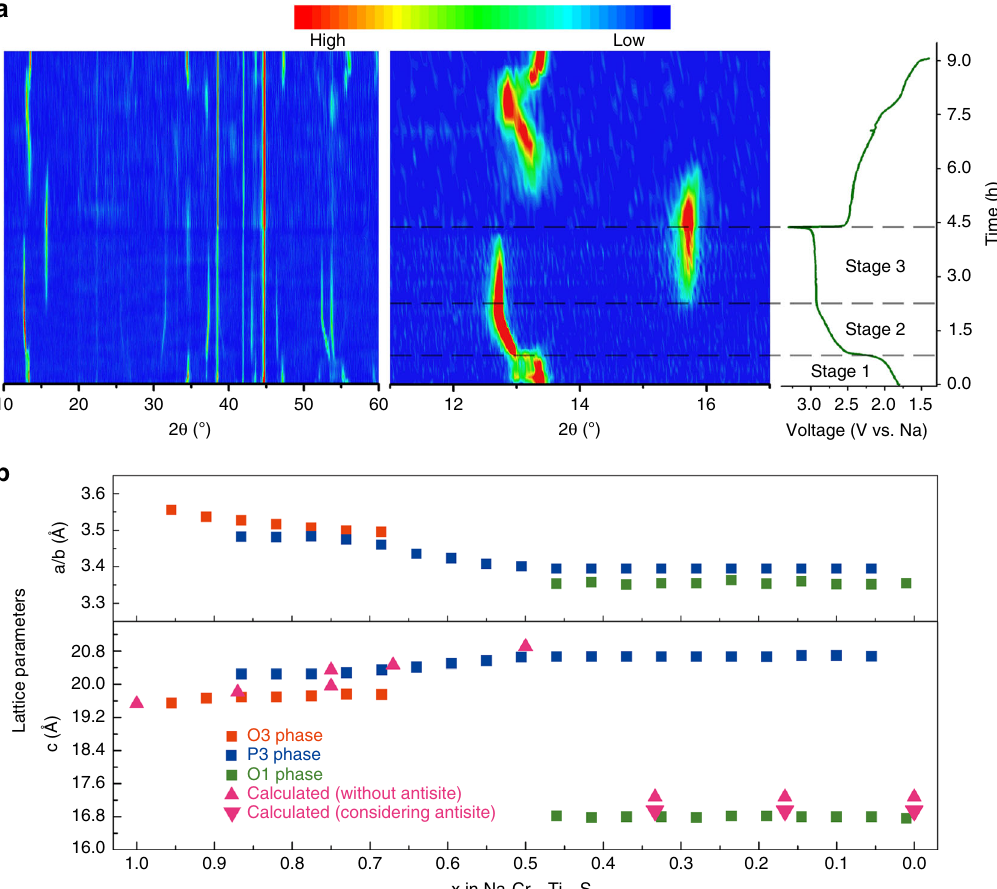
Fig. 2 Structural evolution of NaCr 2/3 Ti 1/3 S 2 during cycling. a In situ XRD contour for NaCr 2/3 Ti 1/3 S 2 cell cycling at a rate of C /5. The constant intensity peaks at 38.54°, 41.98°, and 44.82° are peaks of Al foil. b Lattice parameters calculated from the in situ XRD and from density functional theory (DFT) calculations as functions of composition during the fi rst charge. For easy comparison, c length of full charged O1 ′ phase is three timed to accord with O3/P3